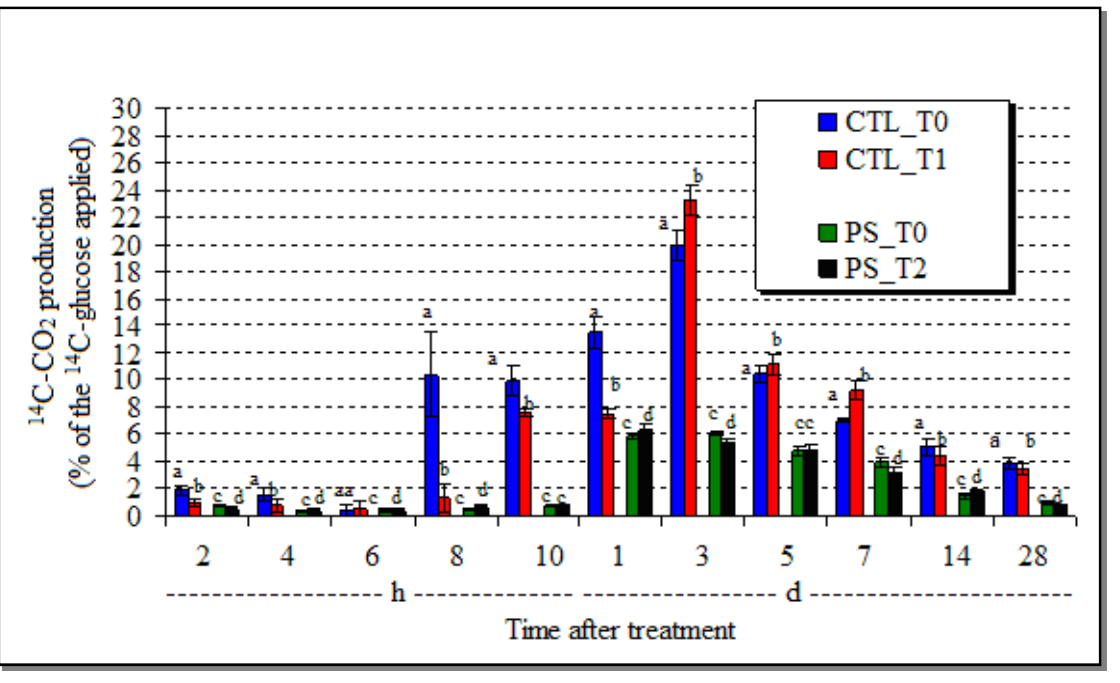
Figure 1. Substrate ( 14 C-glucose)-induced respiration of the soil GHE treated either with chlorothalonil (CTL_T1) or the P. sonchifolia methanol extract (PS_T2) and their respective controls (CTL_T0; PS_T0), during 28-day incubation. (h = hours; d = days; mean ± SD; different letters near the bars indicate statistical difference in relation to the